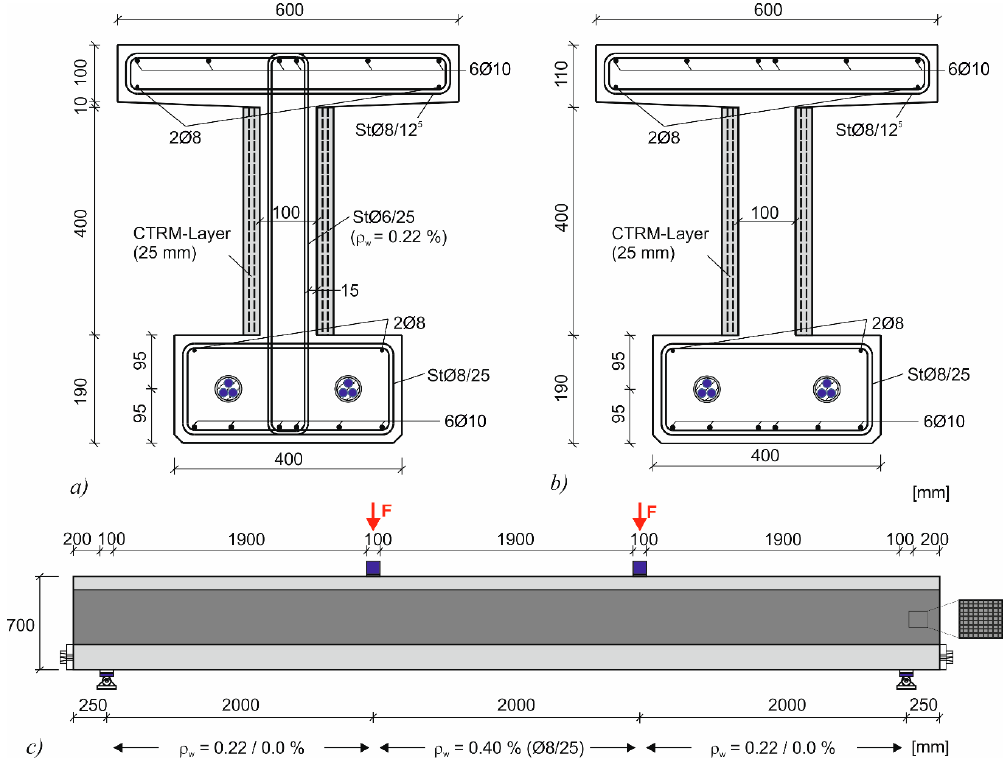
Figure 9. ( a ) Strengthened cross-section with shear reinforcement (CTRM-M-22-7); ( b ) the strengthened cross-section without shear reinforcement (CTRM-I-O-5); and ( c ) the longitudinal system. Table 4. Mechanical properties of the concrete used in beams and the spray mortar.